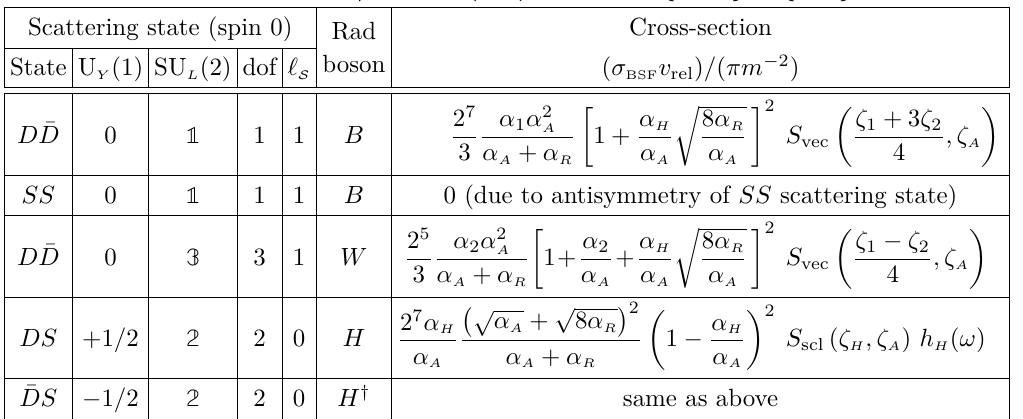
¯ D and S are defined vec scl